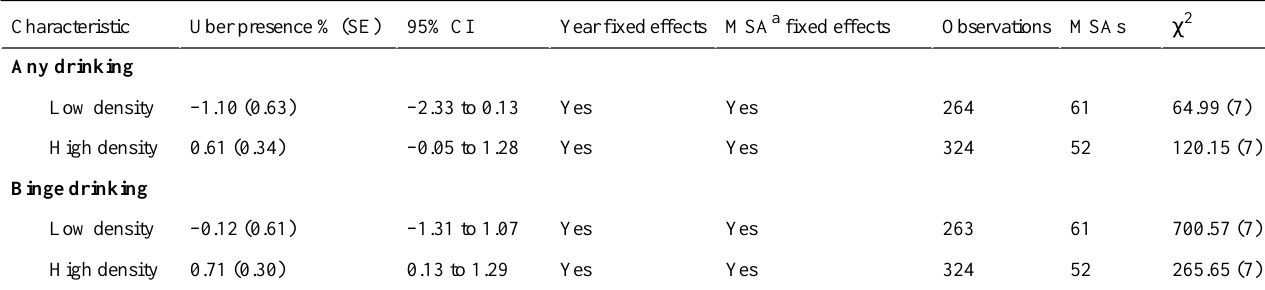
Table 2. Marginal effects of ride-hailing on alcohol consumption in high- and low-density Metropolitan Statistical